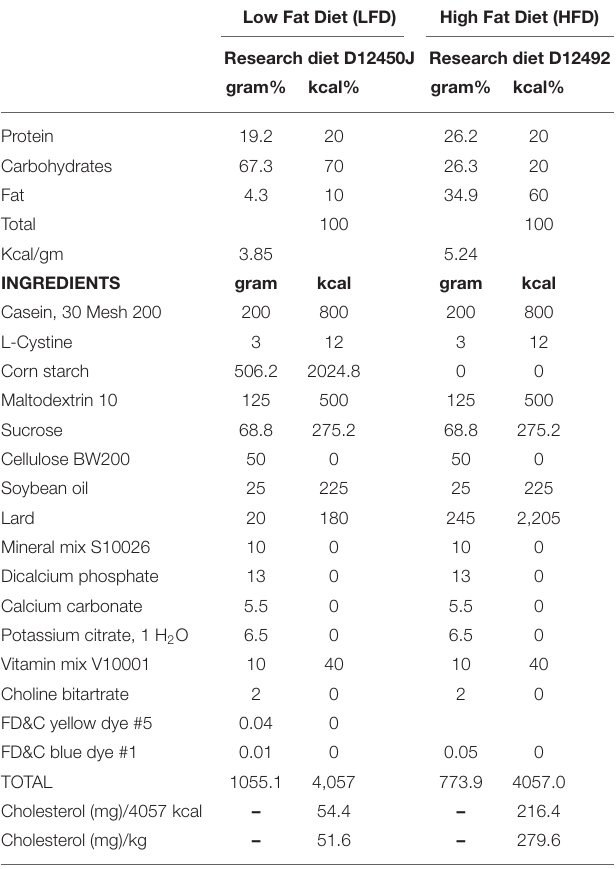
TABLE 1 | Dietary composition of low fat diet and high fat diet. Low Fat Diet